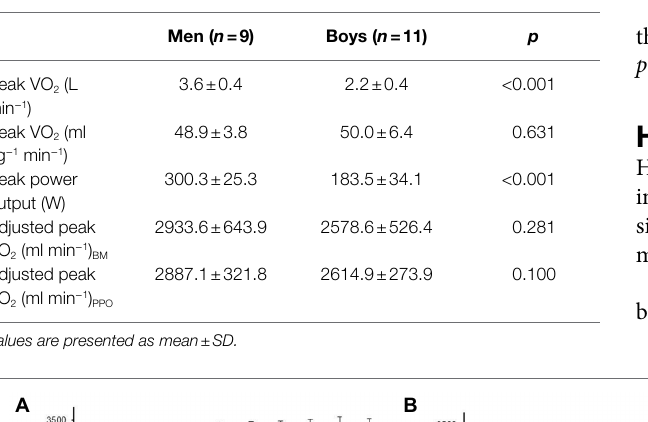
TABLE 2 | Peak oxygen uptake (VO 2 ), peak power output (PPO), and peak VO 2 adjusted for body mass (BM) and PPO in boys and